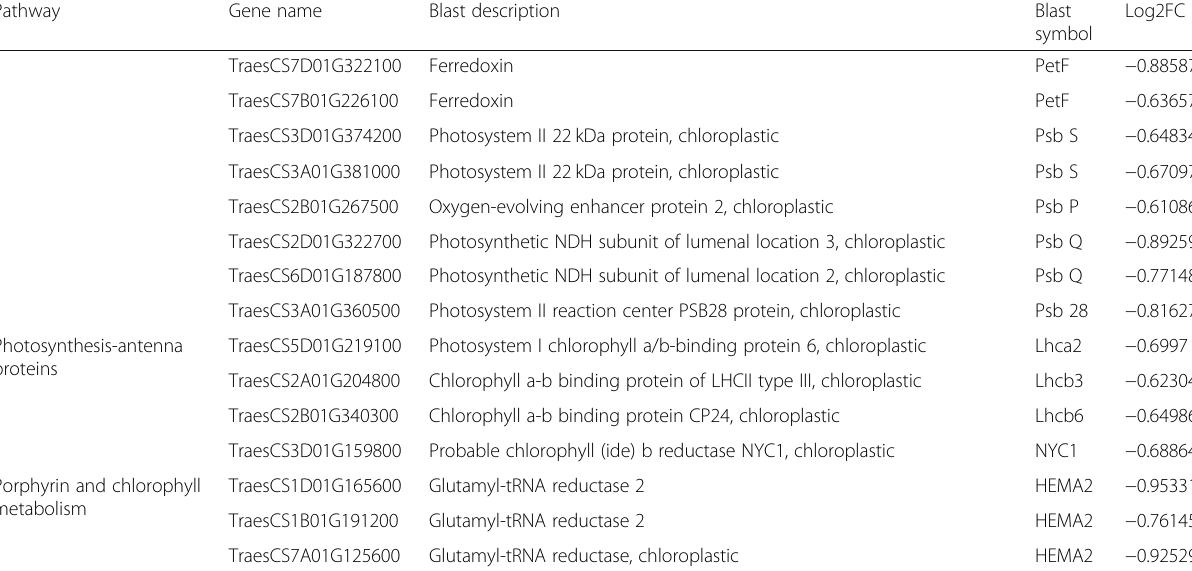
Table 3 List of differentially expressed genes related to photosynthesis and chlorophyll (Continued)